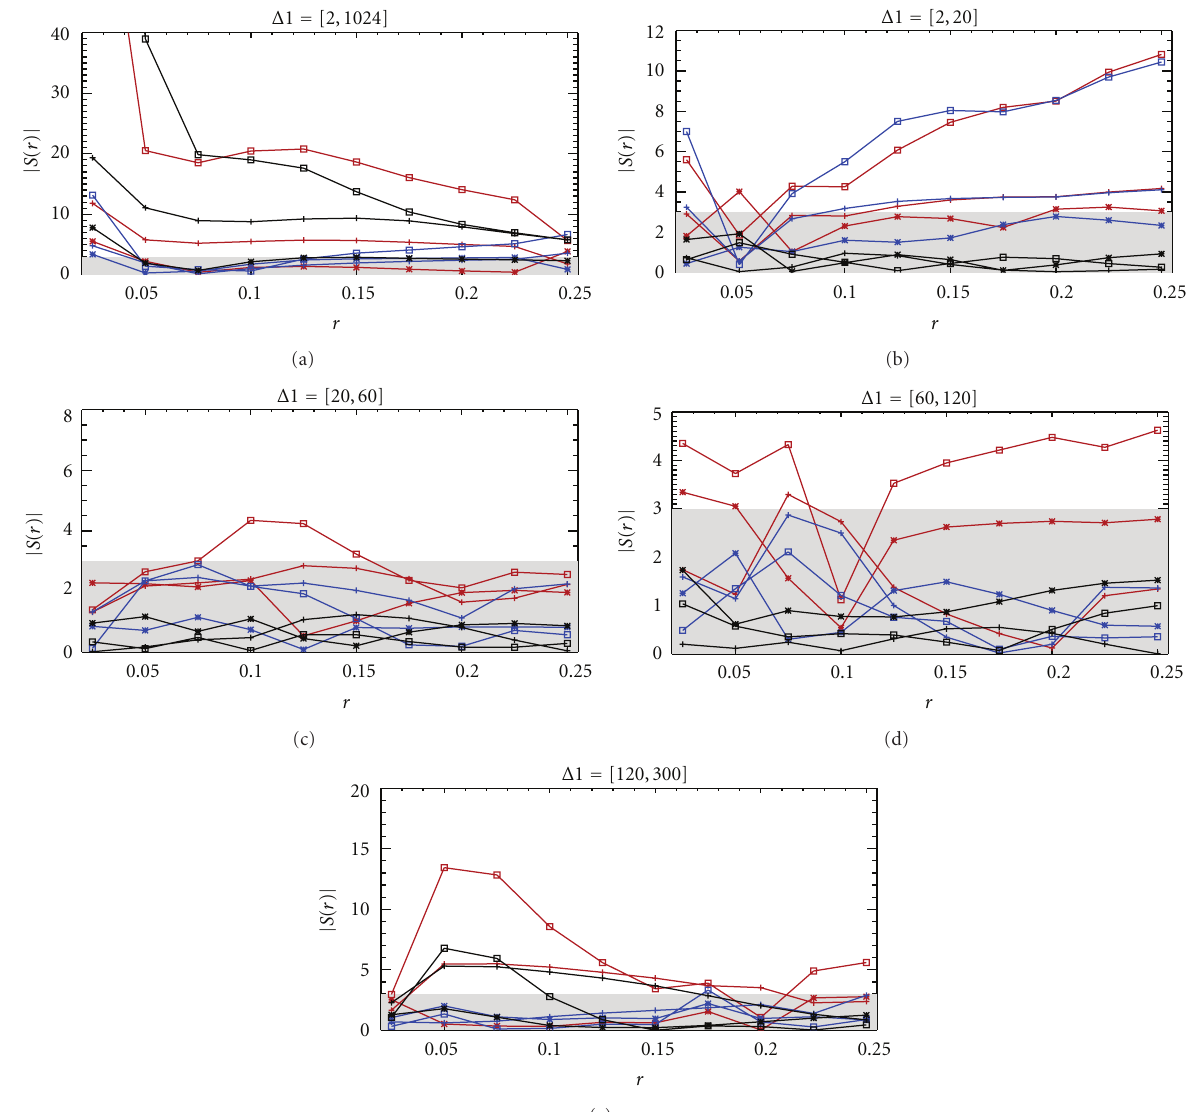
Figure 15: Same as Figure 14, but for the NILC5